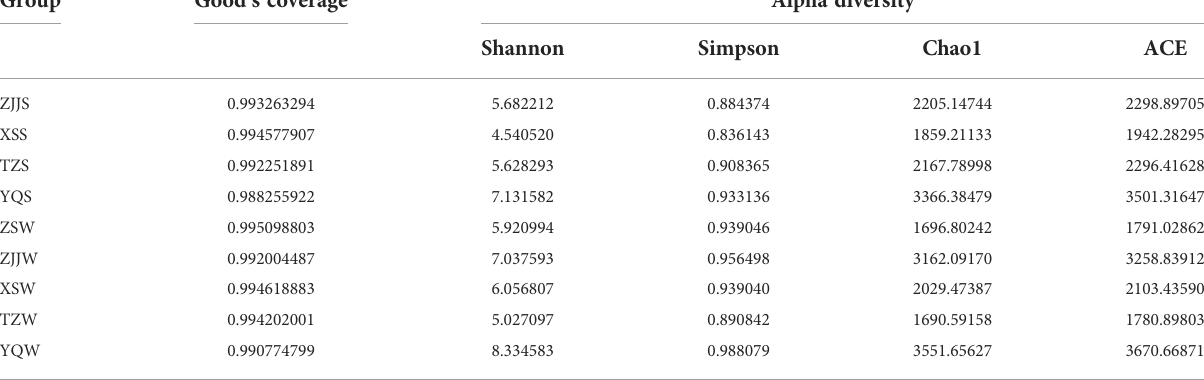
TABLE 1 Richness and diversity indexes of species in all nine groups at the similarity threshold of 97%. Group